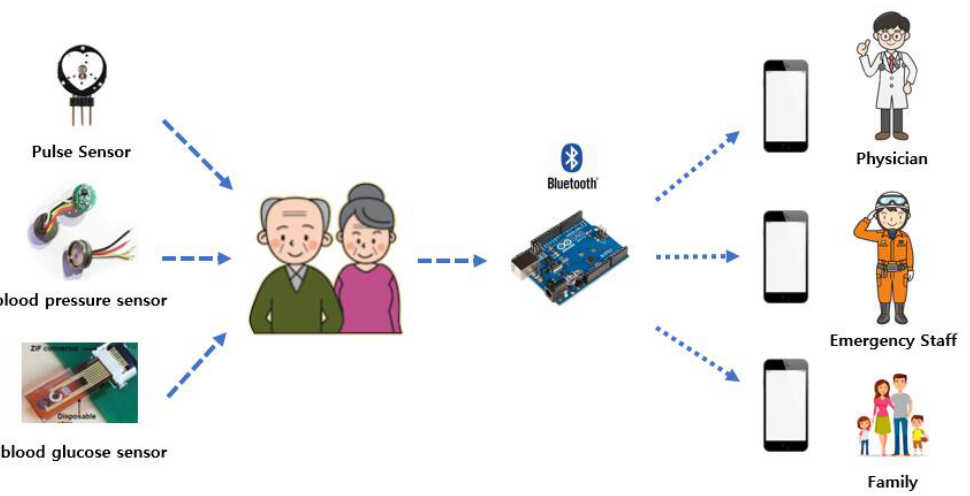
Figure 1. Framework for healthcare for the elderly using wireless body area networks (WBANs) .